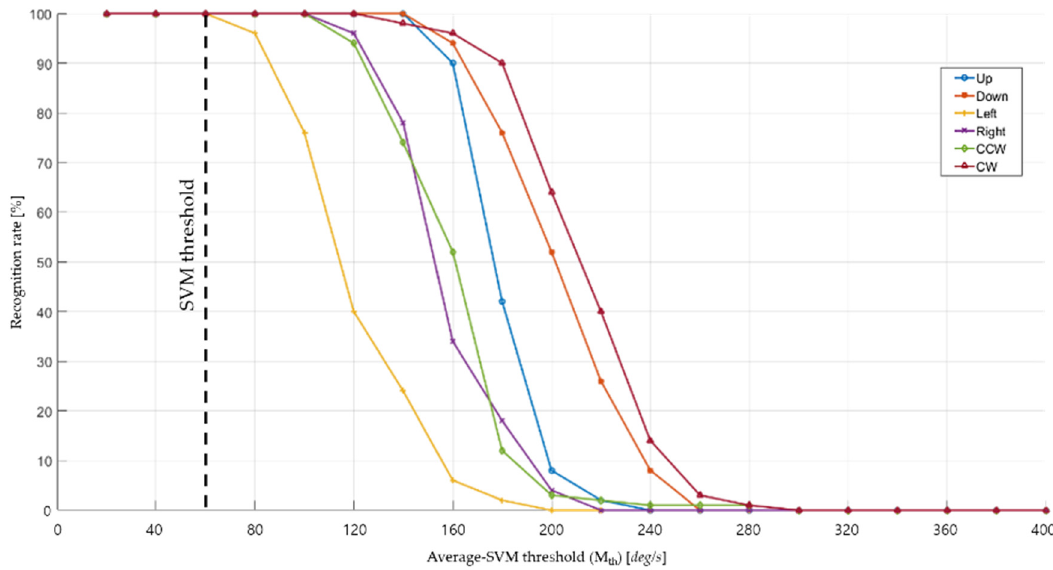
Figure 4. Recognition rates of each hand gesture by the function of threshold average SVM values.